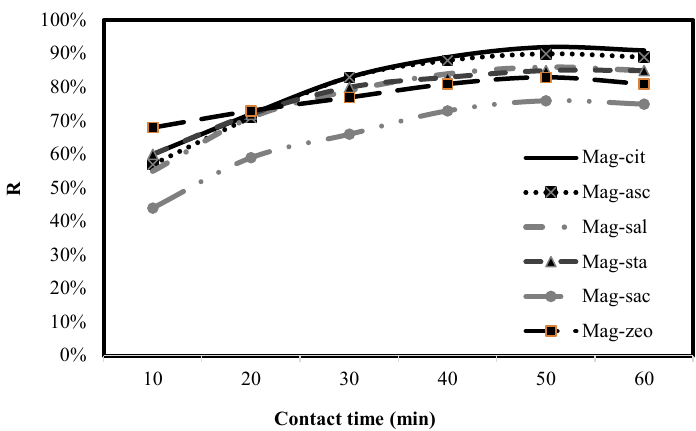
Fig. 10. Effect of contact time on the removal of Co(II) (adsorbents dose: 0.2 g, Co(II) concentration: 25